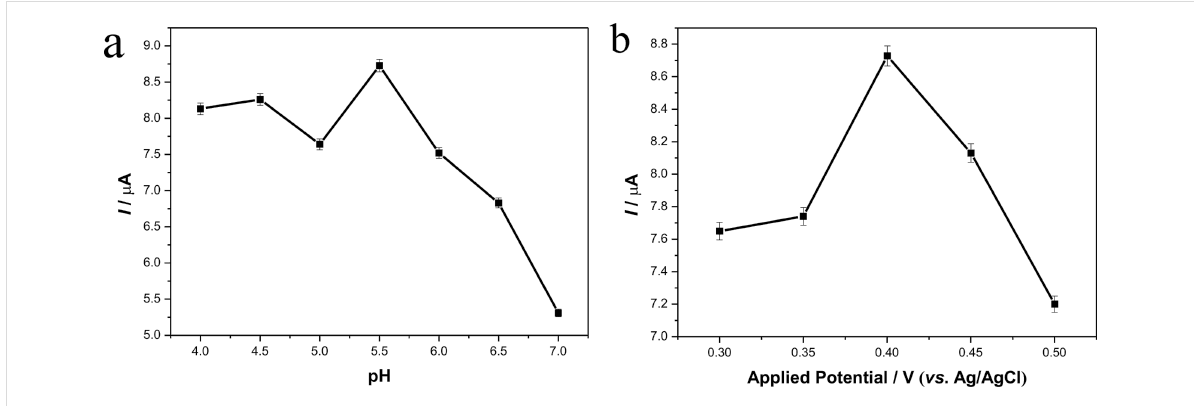
Figure 7: Influences of solution pH (at 0.4 V) (a) and applied potential (pH 5.5) (b) on the steady-state current response of 200 µM catechol in 0.2 M acetate buffer.